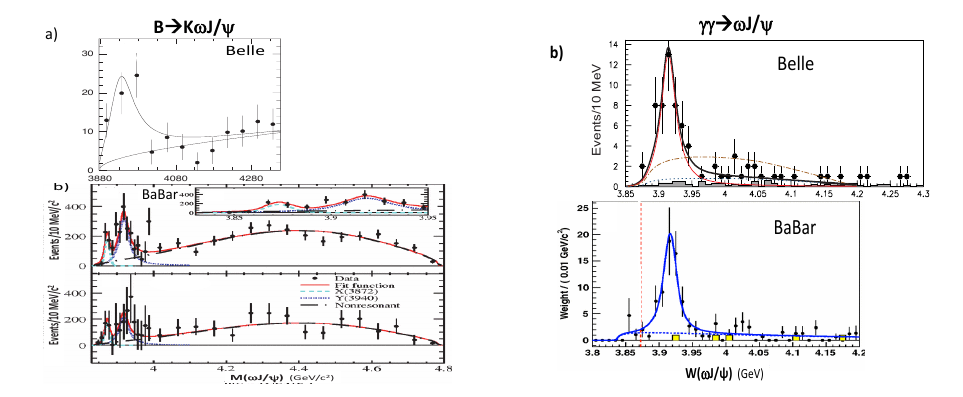
Figure 1. a) The ω J /ψ invariant mass spectrum for B → K ω J /ψ decays from (top) Belle [2] and (bottom) Babar [4]. The low mass peak in the BaBar data is attributed to X (3872) → ω J /ψ (see inset); the higher mass